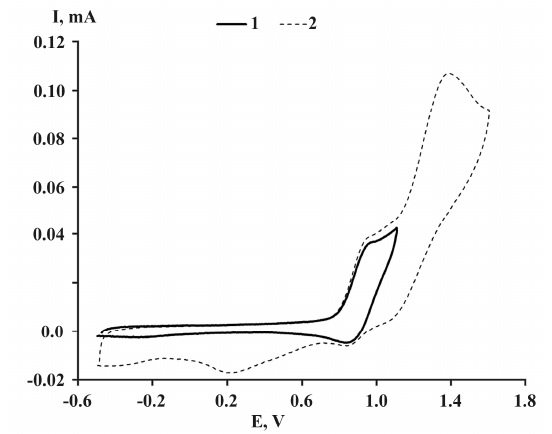
Figure 6. Cyclic voltammograms of compound 1 (in the potential switch from − 0.5 to 1.1 V—curve 1; in the potential switch from − 0.5 to 1.6 V—curve 2) (CH 2 Cl 2 , C = 3 mM, 0.15 M TBAP, scan rate 200 mV·s − 1 ). The value of the peak potential E ox2p = 1.39 V on the CV of 1 is fixed in the potential range of 1.37– 1.60 V, which is characteristic of the second redox process “ o -semiquinone / o -benzoquinone” in such